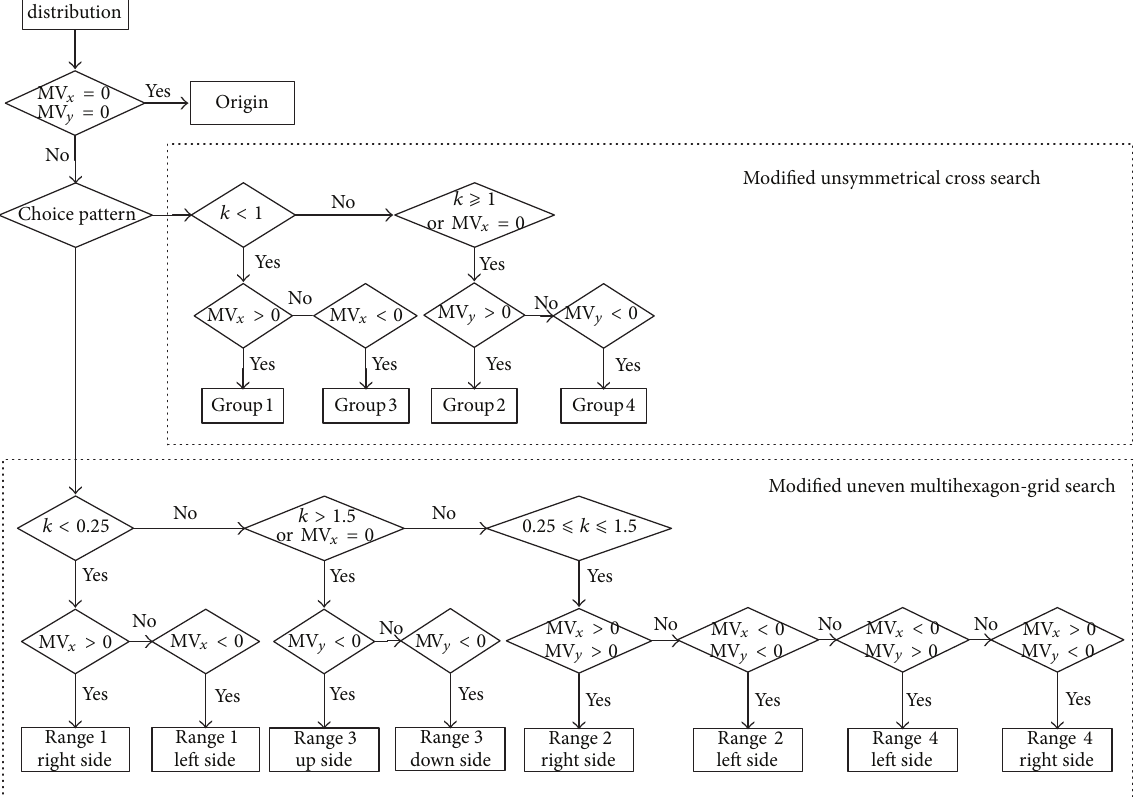
Figure 7: Flow chart of predicting the direction of MV.